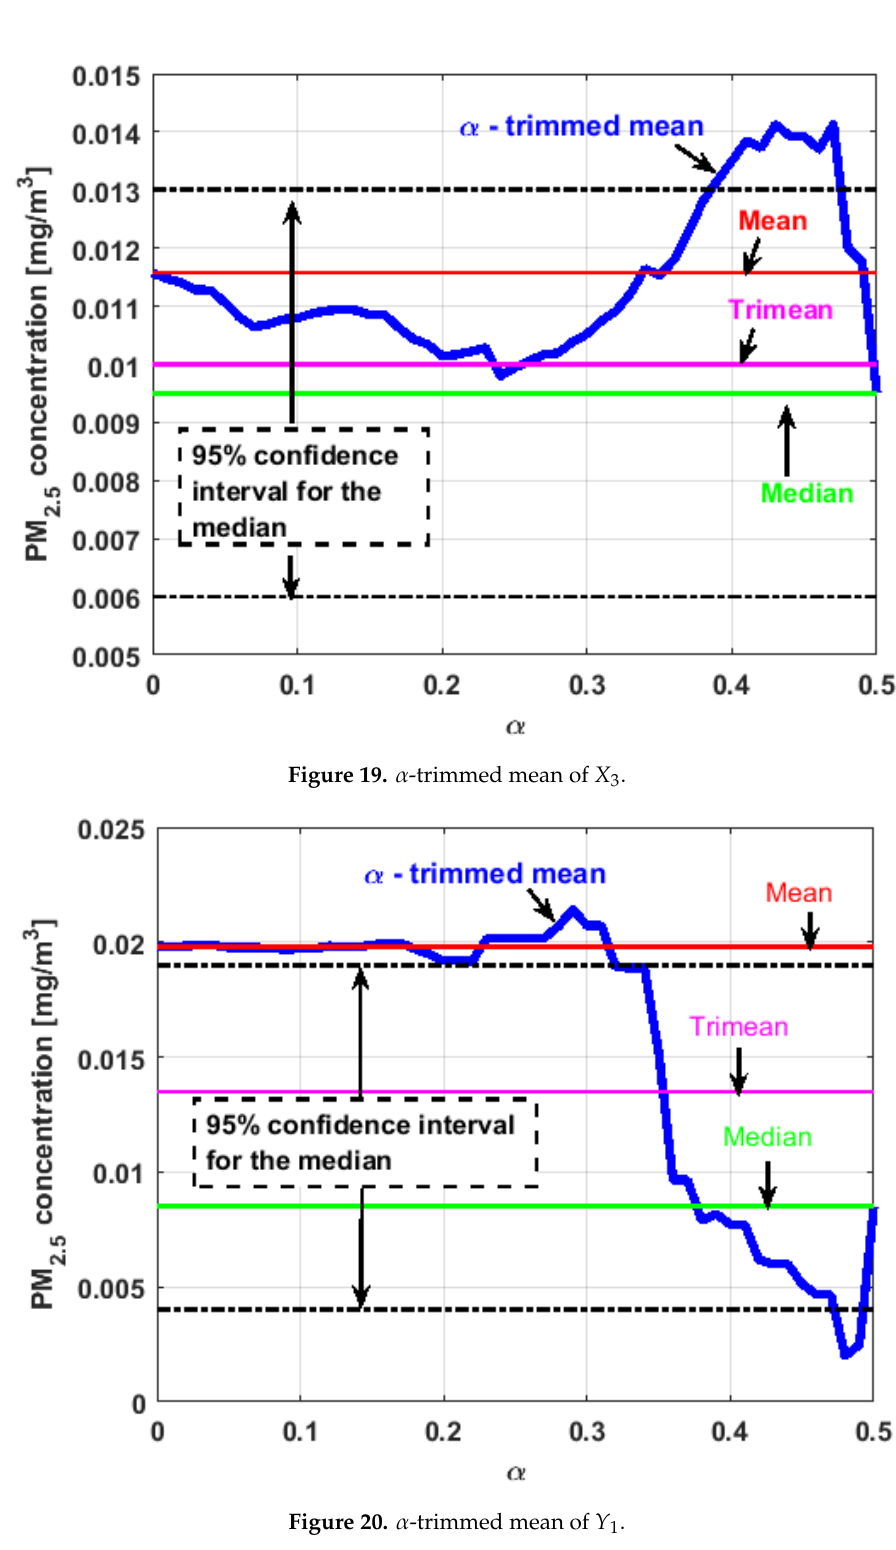
Figure 20. α -trimmed mean of Y 1 Figure 20. 𝛼 -trimmed mean of 𝑌 1 . Figure 20. 𝛼 -trimmed mean of 𝑌 1 .